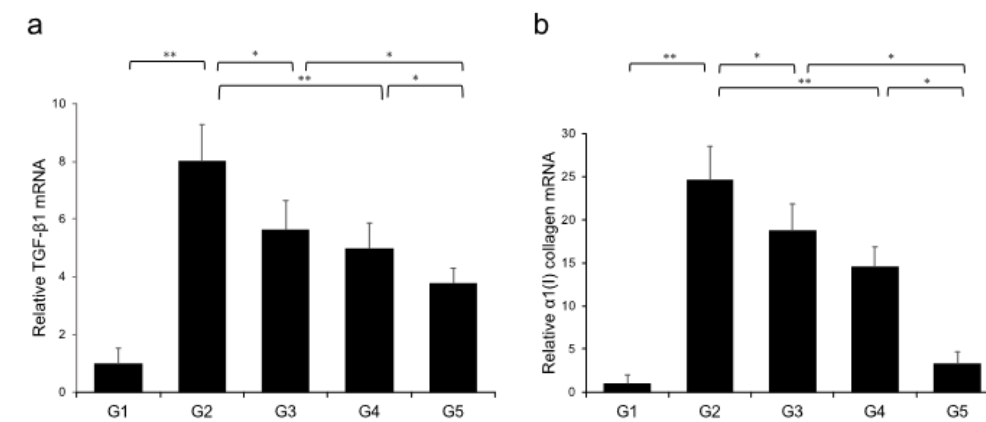
Figure 3. Effects of canagliflozin (CA) and teneligliptin (TE) on hepatic mRNA expression of TGF- β 1